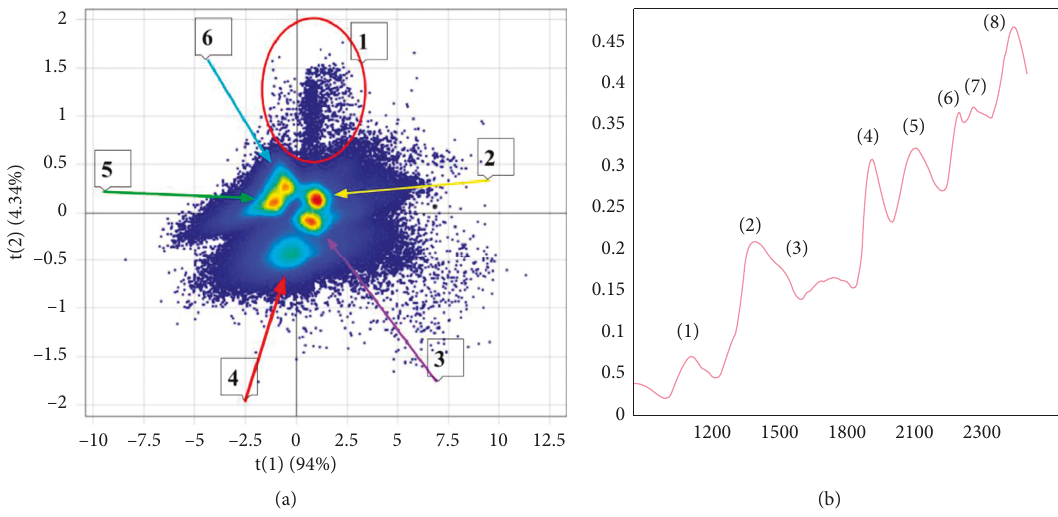
Figure 4: (a) Score plot after background image cleaning, and (b) average spectrum of image related to the surfaces of the naturally seasoned and kiln-dried specimens shown in Figure 3(a) (numbers relate to description below and to Table Table 2: Band assignment from average spectrum of naturally seasoned and kiln-dried wood. Peak no. in Figure 4(b)